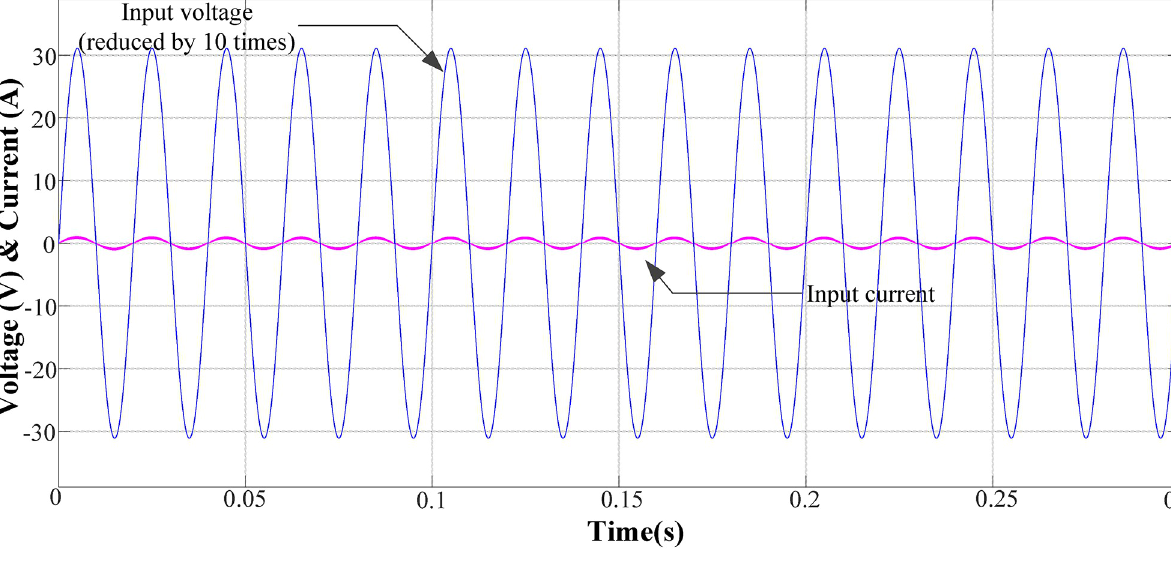
Fig 8. Input voltage and current waveforms in normal operation